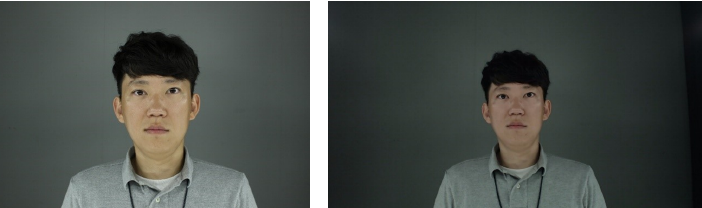
Figure 6. Example of facial region size differences for two images of the same person obtained using different cameras.